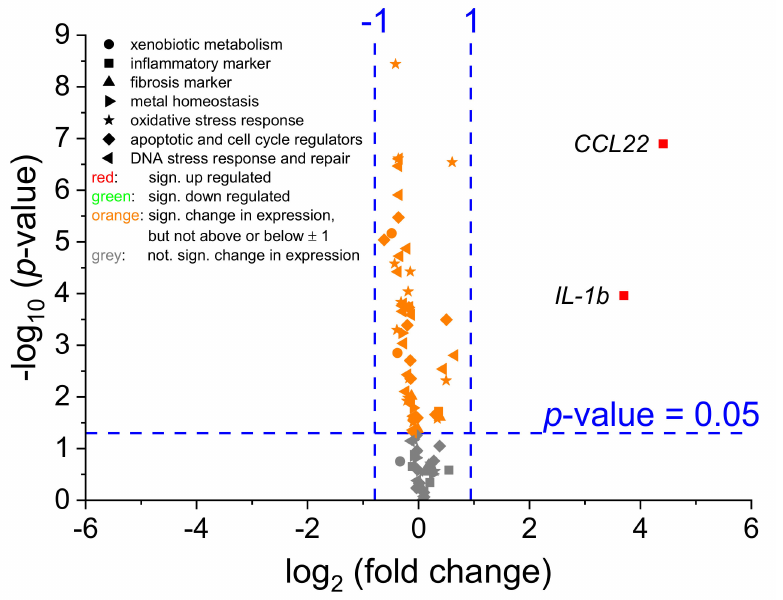
Figure 3. Differences in gene expression between untreated mono- (A549) and co-culture (A549 + dTHP-1) using a high-throughput RT-qPCR system. The volcano plot displays the extent (log 2 (fold change), x -axis) and the statistical significance ( − log 10 ( p -value), y -axis) of gene expression alterations between the co-culture compared to the monoculture. Vertical lines indicate a relevant expression change of 50% reduction ( − 1) or doubling (+1). The horizontal line displays the statistical significance threshold ( p ≤ 0.05, n = 3, independent samples t -test). Red: significant up-regulated genes. Green: Significant down-regulated genes. Orange: significant changes in gene expression, but not considered relevant ( − 1 ≤ x ≤ 1). Grey: no significant change in gene